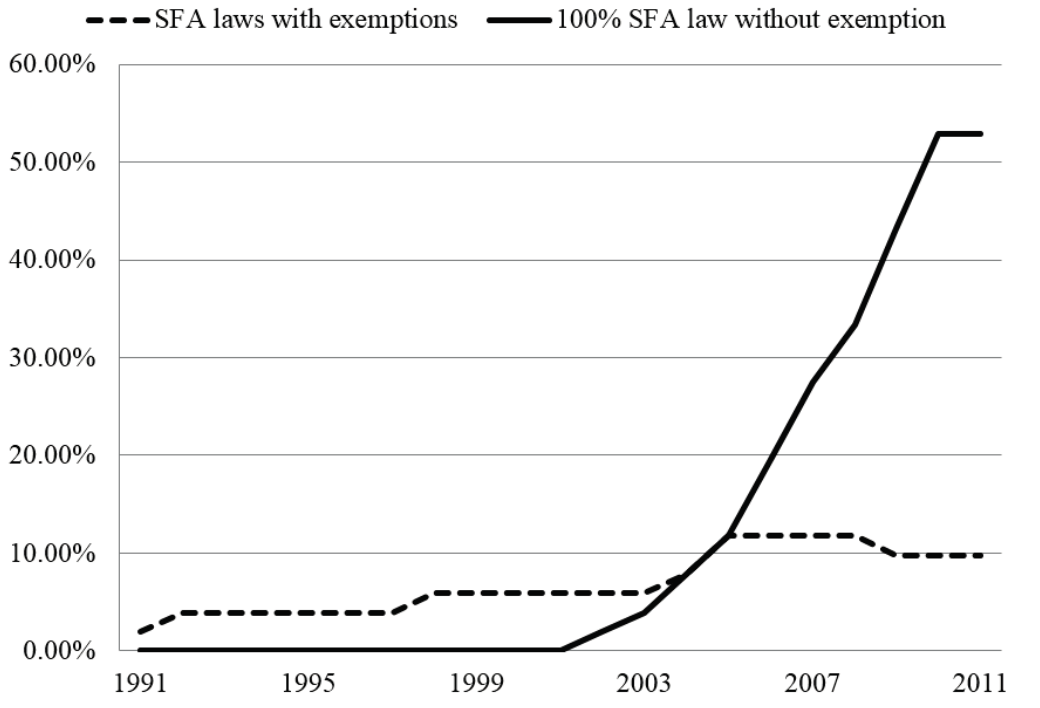
Figure 1. The Prevalence of smoke-free air (SFA) Laws in Bars in 50 States and